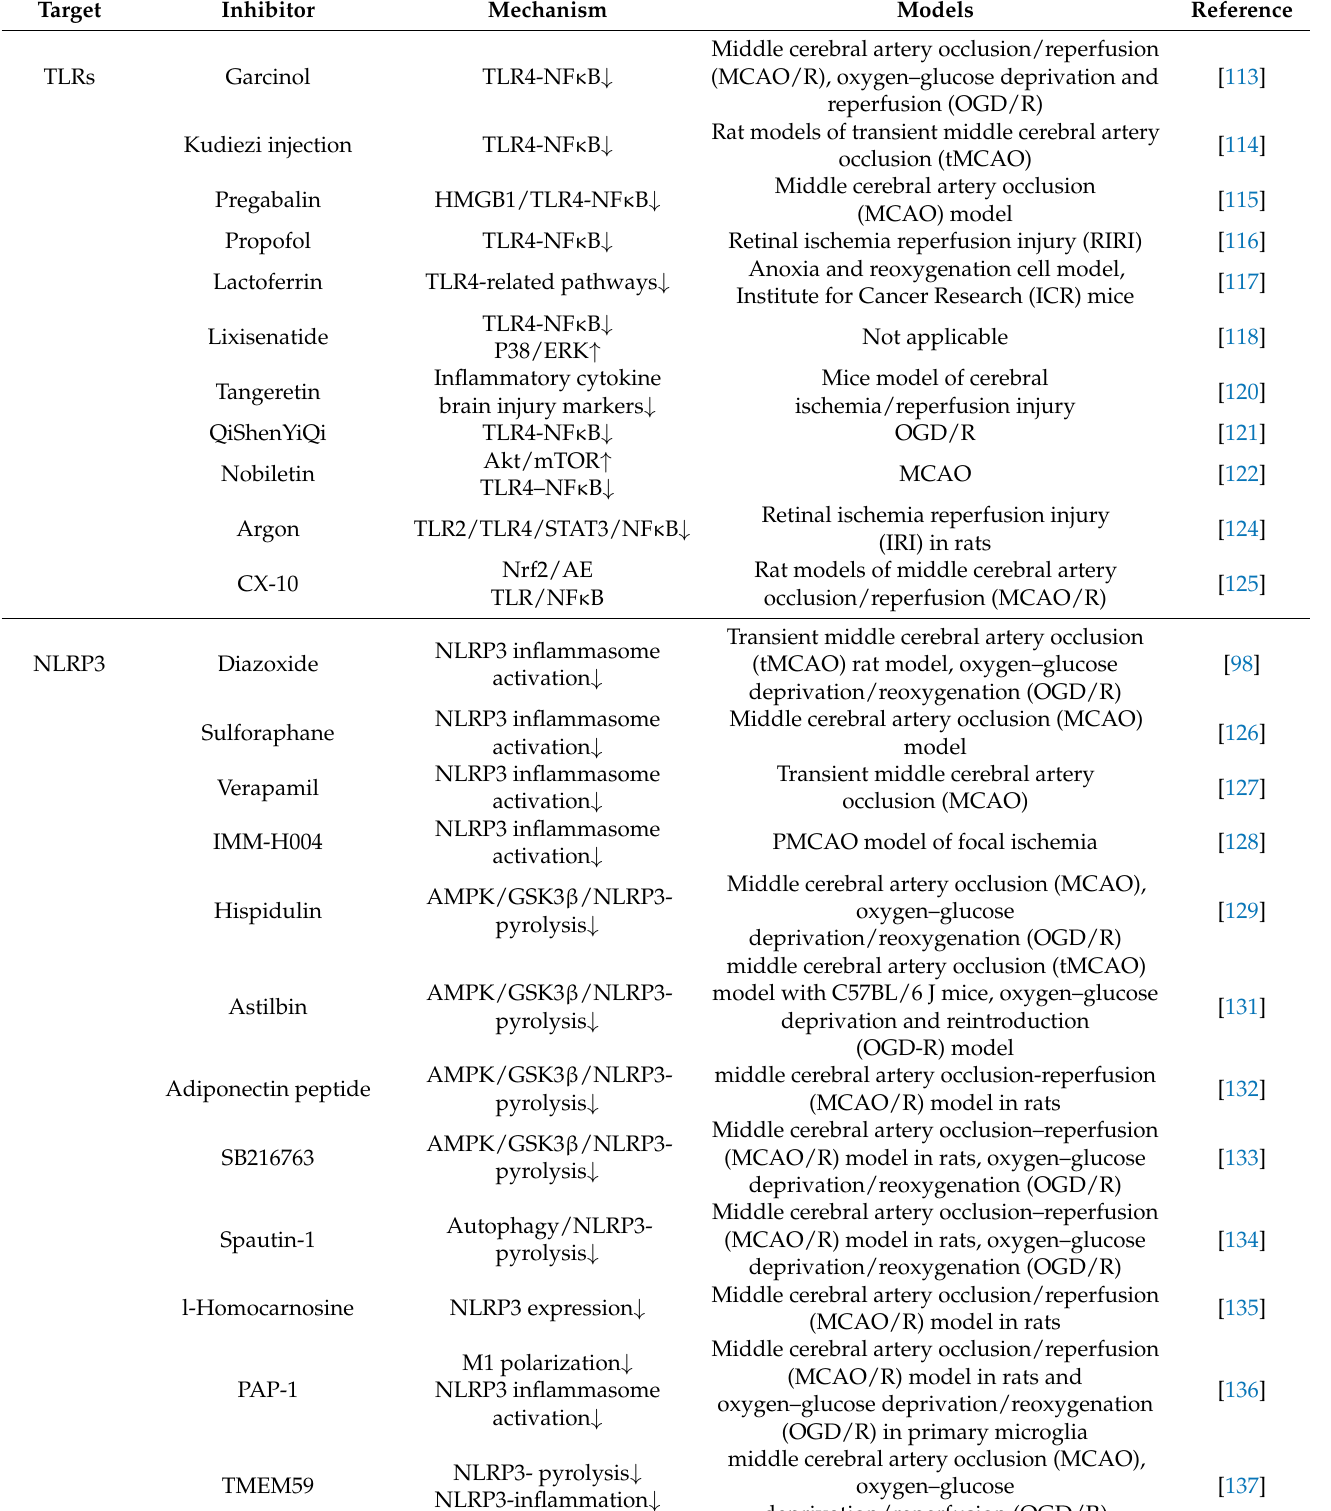
Table 1. mtDNA driven inflammation and macrophage metabolism targeted therapy for cerebral ischemia-reperfusion injury. ↑ : Activation/Upregulation; ↓ :